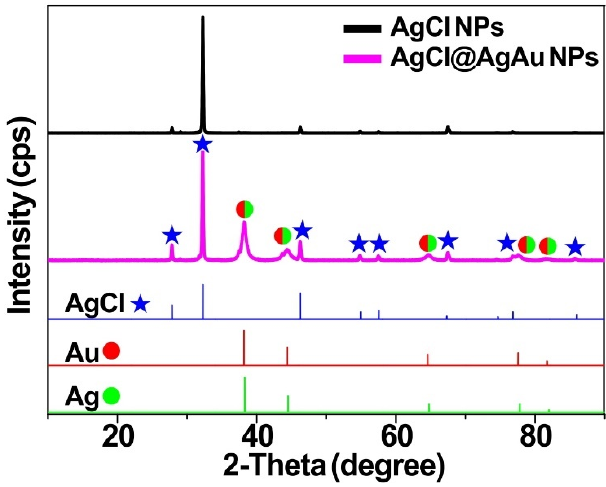
Figure 4. XRD patterns of the 10X AgCl NPs (black) and the 10X AgCl@AgAu NPs (pink). Reference JCPDS patterns for each element are shown below (AgCl in blue, Au in red, and Ag in green).